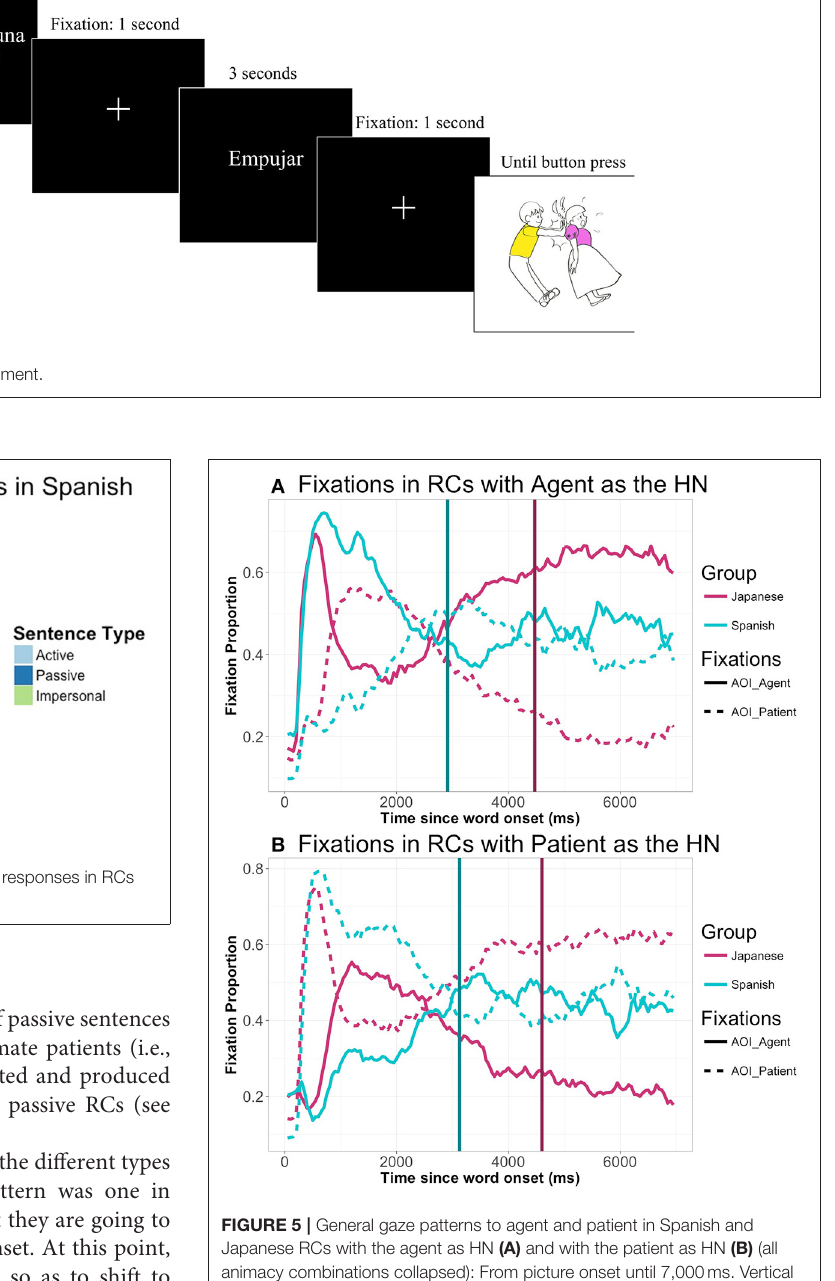
those with the Patient as HN (Agent-HN: 2913 ms., Patient-HN: 3127 ms., t = − 2.769, p =